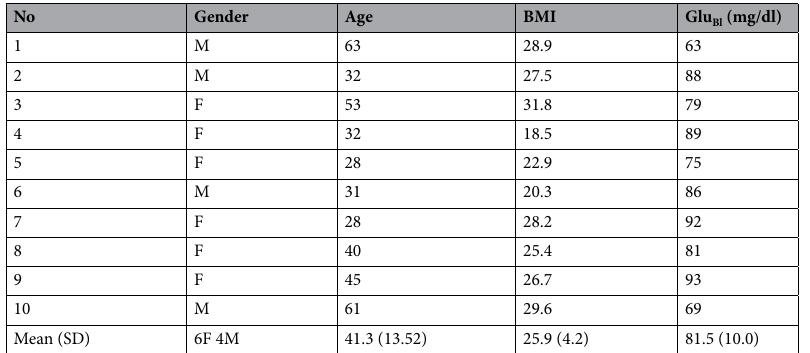
Table 1. Study subject characteristics. This table represent the study subject characteristics; The study subject number (No), gender, age (years), Calculated Body Mass Index (BMI), and baseline glucose values at the beginning of the study prior to the oral glucose tolerance test and use of passive simulated jogging device (Glu Bl ). Mean and standard deviation (SD) for each